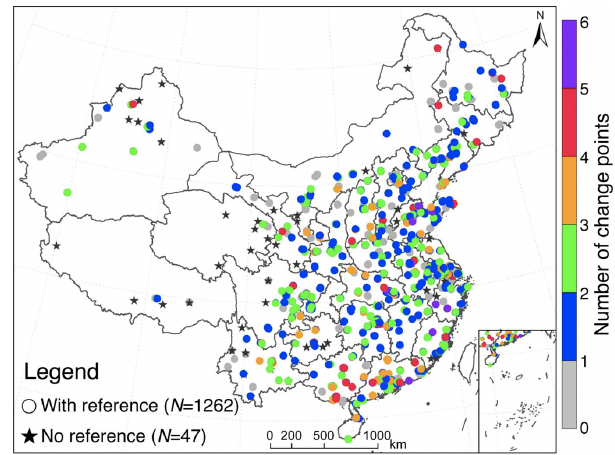
Figure 3. Spatial patterns of the total number of change points detected in each long-term yet consecutive PM 2 . 5 concentration record in the study area. Gray dot indicates there was no change point detected in this PM 2 . 5 concentration